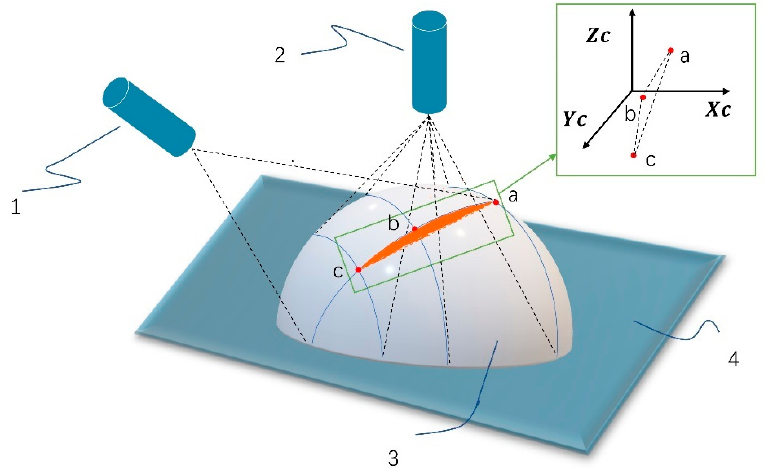
Figure 10. Three points in space determine a plane. (1) Single-line laser, (2) Three-line laser, (3) Object, (4) Experiment platform.